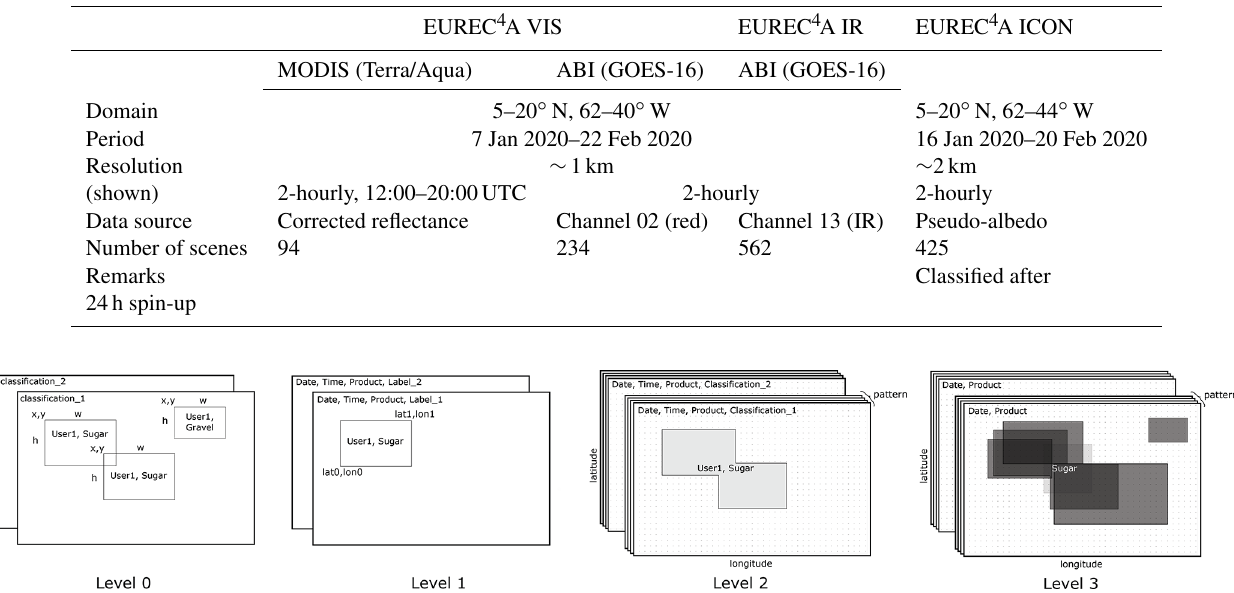
Table 1. Description of data sources used to create the images of the classification workflows.